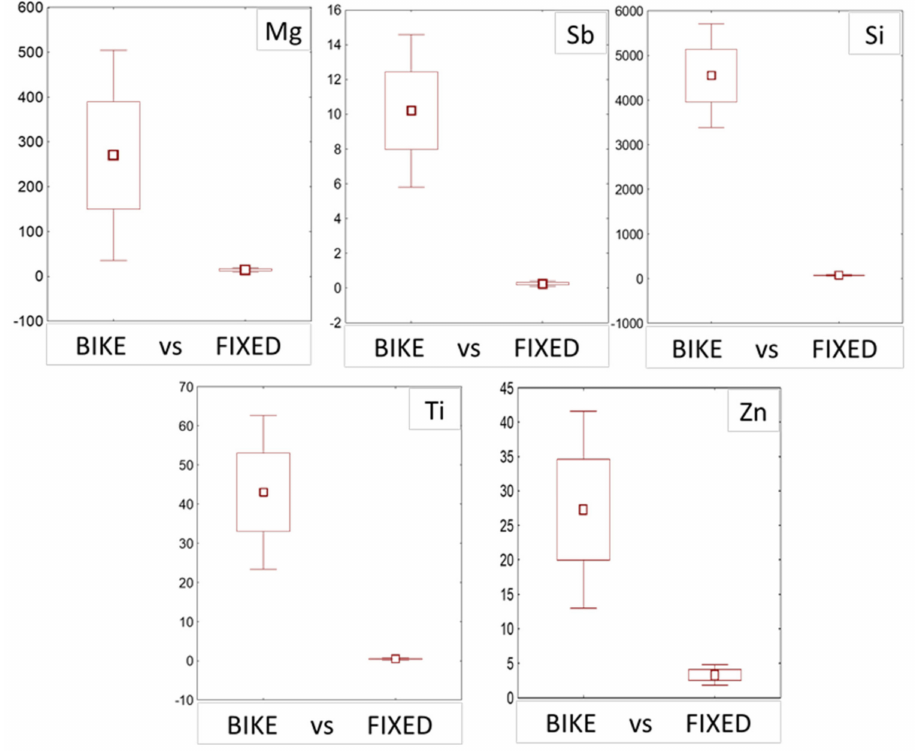
Figure 4. Comparison between fluxes ( y axis; µ g m − 2 d − 1 ) calculated in mosses exposed by bike and in fixed position ( n = 21), all in the urban environment of Antwerp. Square: Mean; box: Mean ± SE; Whiskers: Mean ± 1.96 ∗ SE. For all the comparisons p < 0.05, according to the t -test for indepen- dent samples.